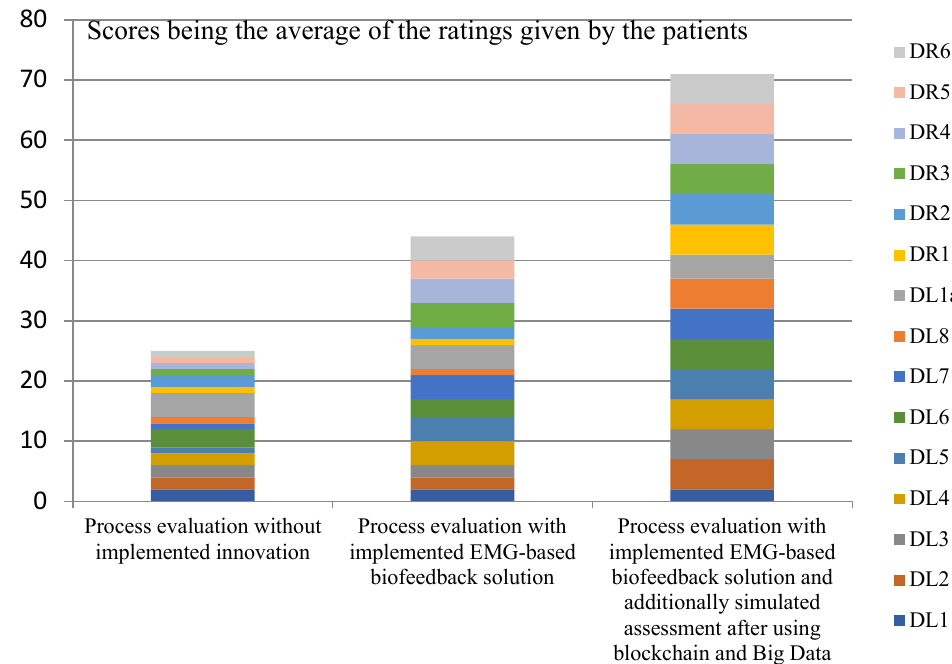
Figure 2. Assessments of the process steps in terms of the creation of values for the patient’s phys- ical health. Source: Authors’ own elaboration based on primary studies.